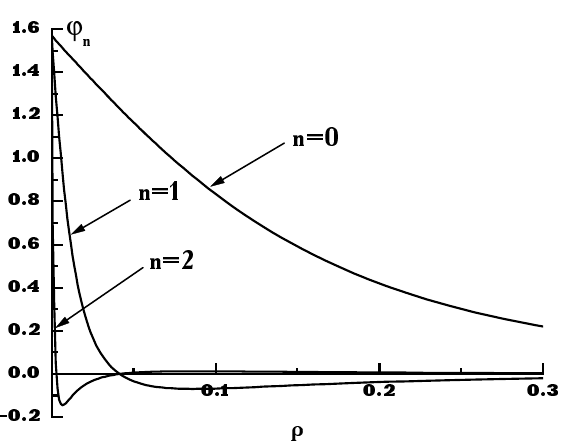
Figure 1. The first solution, ϕ 0 ( k ), of the mass gap equation, representing the vacuum | 0 (cid:5) and its two first two other solution, ϕ ( k ) 1 and ϕ ( k ) 2 for a linear confining potential [12, 13], corresponding to the truncated Coulomb gauge of QCD), computed in the chiral limit of m q barq = 0.